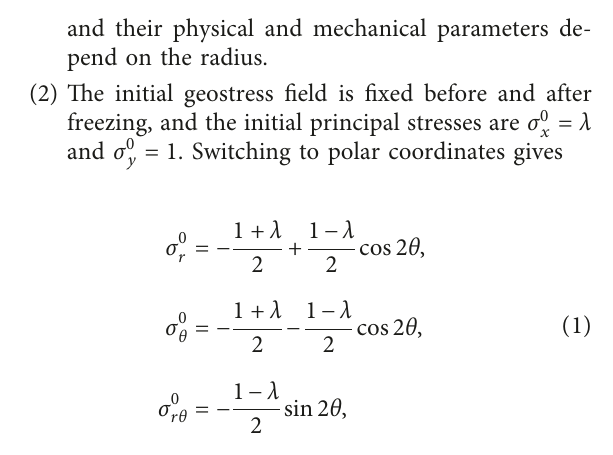
Figure 1: Mechanical model I: the mechanics model for interactions between a heterogeneous frozen wall and surrounding rock in the unloading